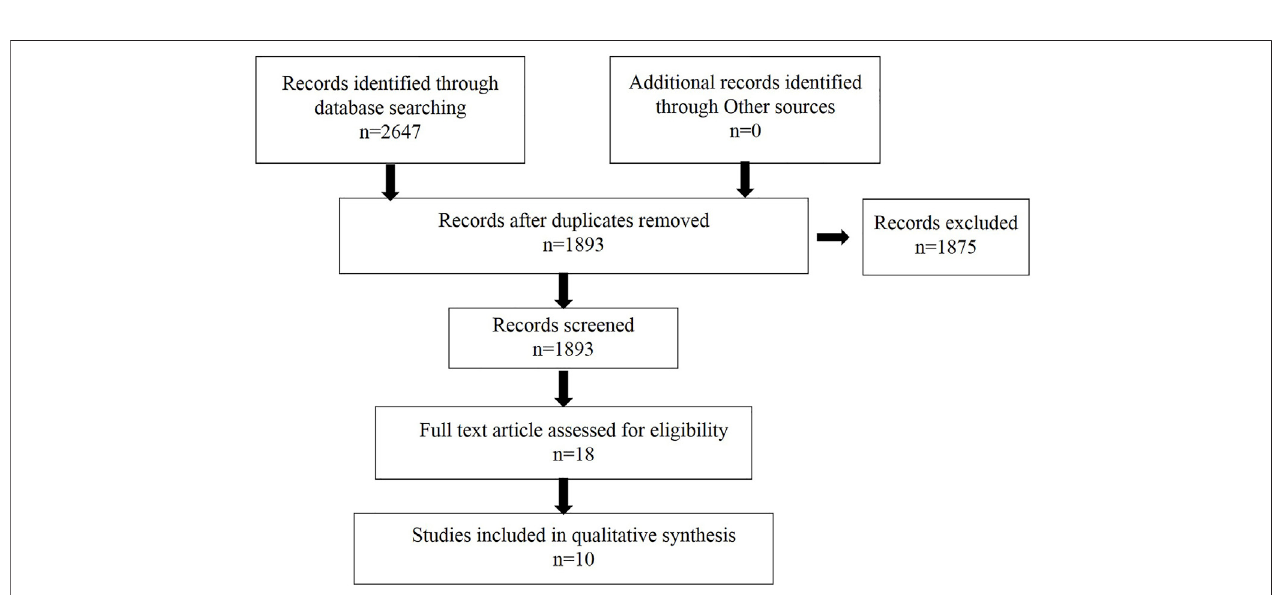
FIGURE 2 | Flow chart of literature research used to retrieve information to identify potential extracts for dementia treatment.